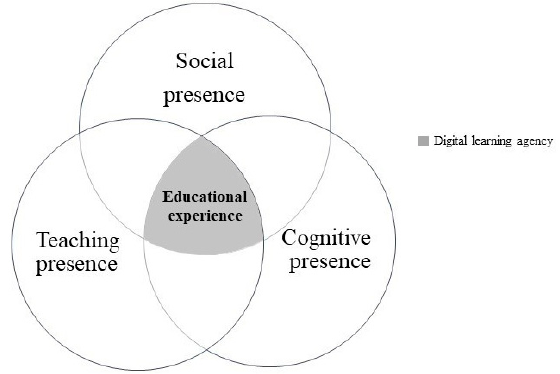
Figure 5. New COI version for middle school students in online environments .